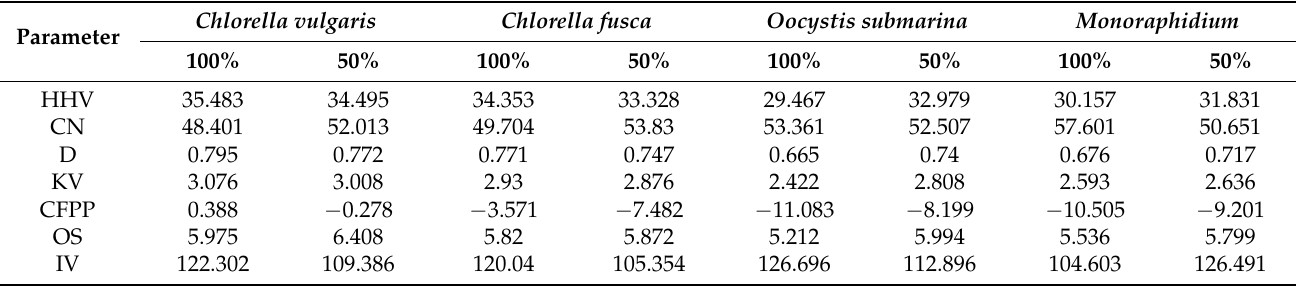
Table 2. Biodiesel fuel properties calculated on fatty acid profile.